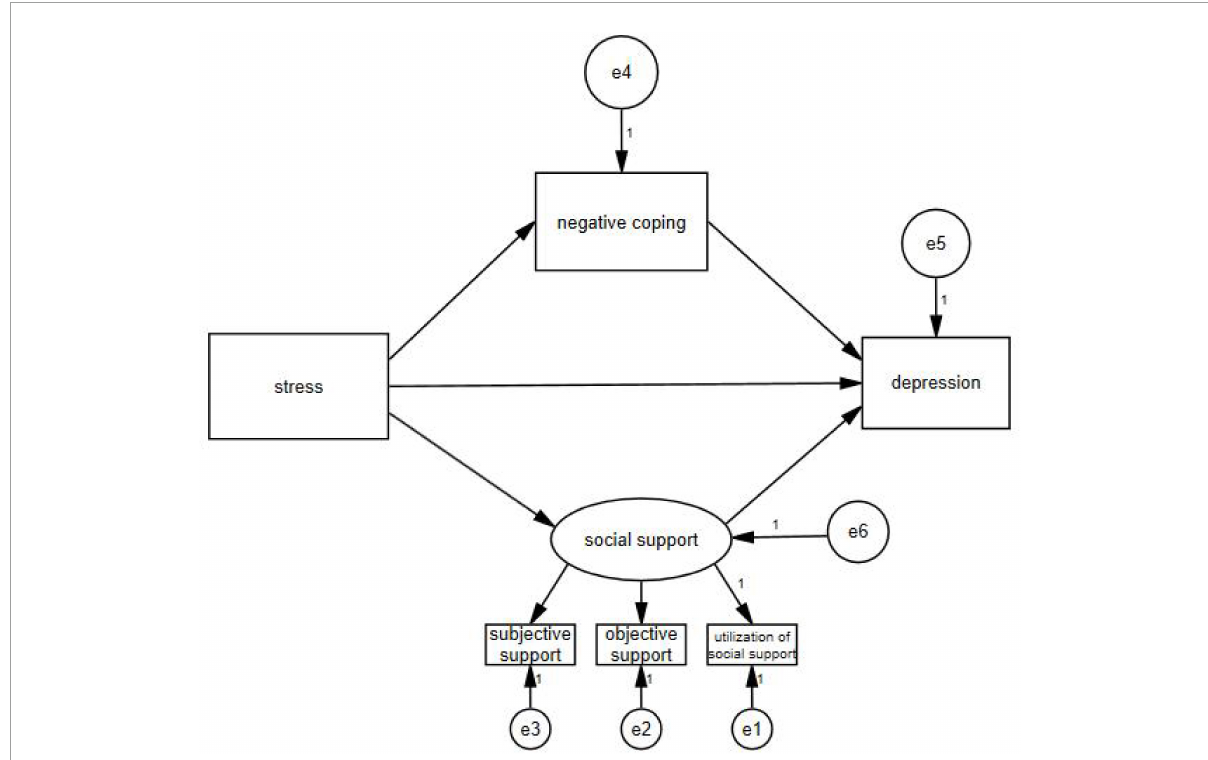
FIGURE2 Final structural equation model on depression. e1–e6: the sign of the measurement error.